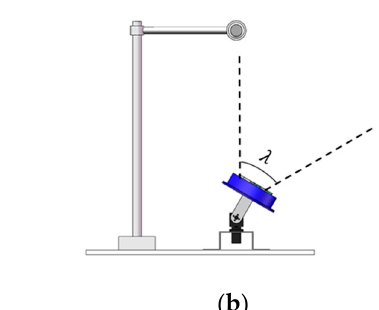
Figure 22. VSICE FOV curve, where V is half the FOV of VSICE. Through the actual FOV test of the compound eye, it can be fitted into a FOV field control curve regarding the air pressure P. The curve shows that when the air pressure of the compound eye is 0, the FOV of the compound eye is the original FOV of the sensor.